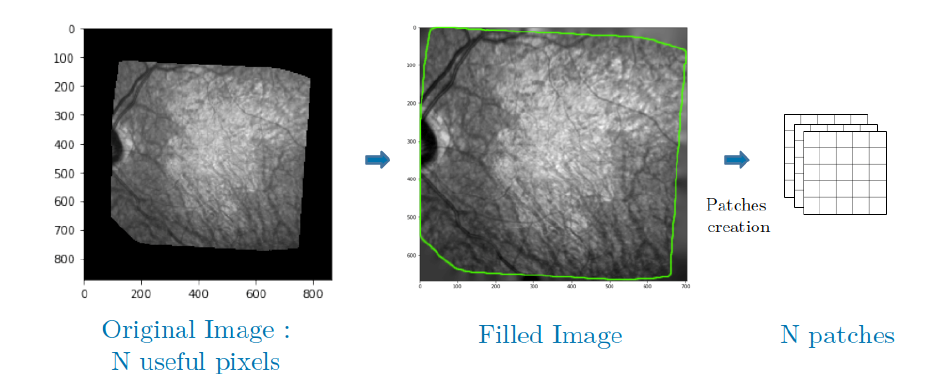
Figure 4. Patches construction,useful pixels are inside the green area.